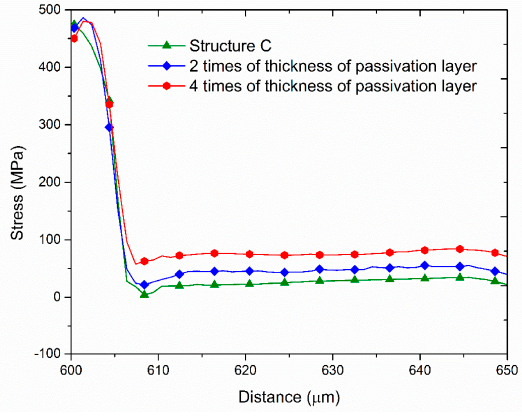
Figure 18. Simulated stress distributions in structures with different passivation layer thicknesses. Table 5. Measured leakage current data in Structure C with different passivation layer thicknesses.